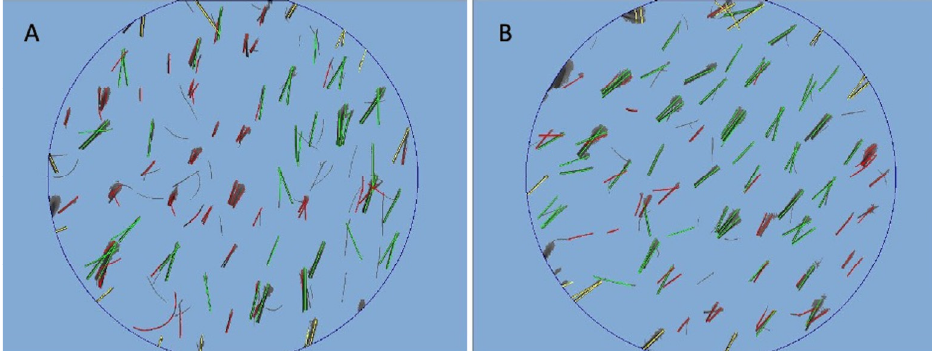
Figure 5. Trichoscan digital image analysis performed by Fotofinder in a patient is shown in Figure 2. ( A ) At T0 pre-operative hair density was 61 ± 2 hairs/cm 2 and proportions of telogen and anagen hairs were 34.4% and 52.3%, respectively; ( B ) at T1 (20 wks) post-operative hair density was 72 ± 2 hairs/cm 2 , and proportions of telogen and anagen hairs were 40.1% and 49.9%, respectively. Table 2. In vivo evaluation using trichoscopy analysis in terms of hair density (HD) (hairs/cm 2 ) improvement.